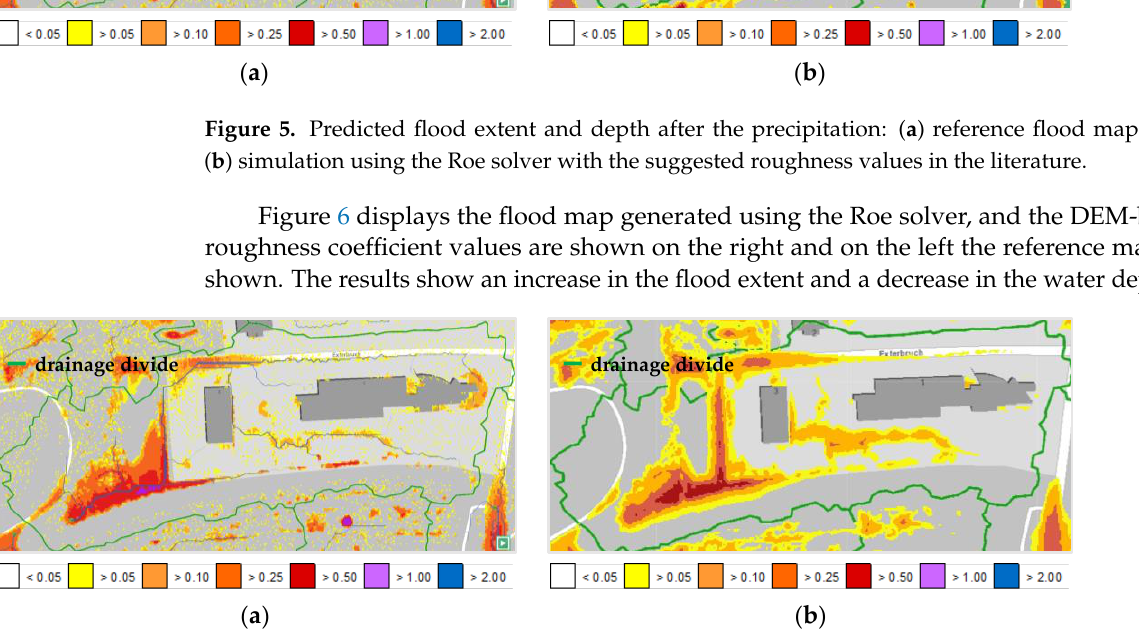
( b ) Figure 7. Predicted flood extent and depth after the precipitation: ( a ) reference flood map [30]; ( b ) simulation using an acceleration solver, and the SWMM manual roughness coefficient values . Figure 8 displays the flood map generated using the acceleration solver, and the DEM-base roughness coefficient is shown on the right and on the left the reference map is shown. As shown in the pictures, the predicted and reference maximum flooding depths and extents are very similar. ( a ) ( b ) Figure 8. Predicted flood extent and depth after the precipitation: ( a ) reference flood map [30]; ( b ) simulation using acceleration solver, and the DEM-base roughness coefficient values. The two spots specified on each picture are the most apparent differences between the two maps; the one on the left is caused by the different GIS projections of the two maps; by overlaying the water depth layer on the original DEM file, this can clearly be seen (Figure 9a).